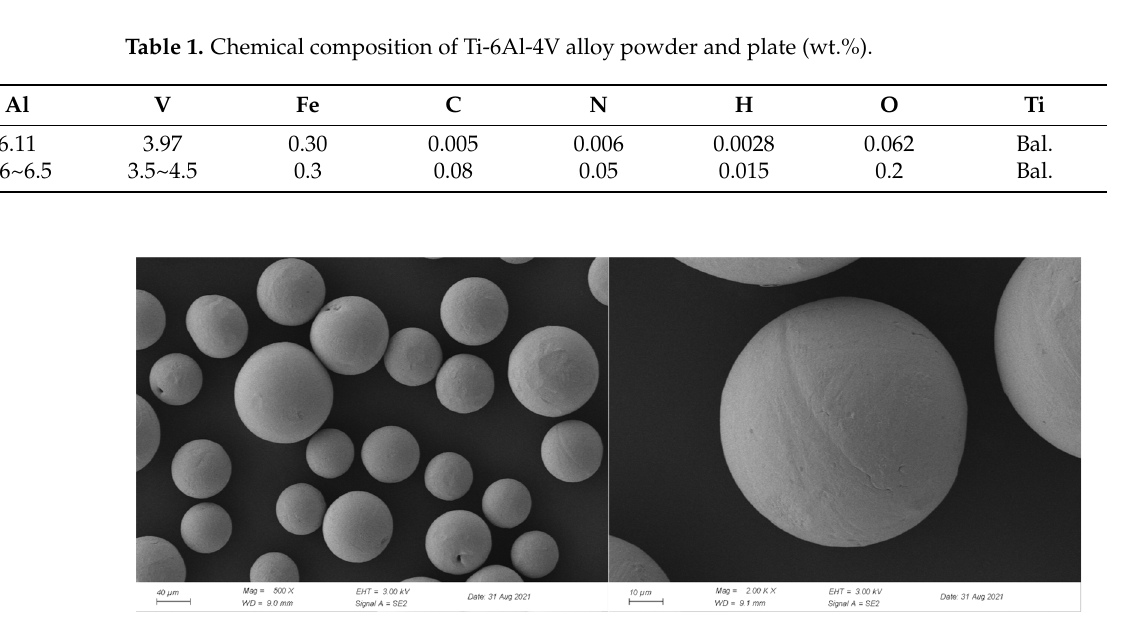
Figure 1. Morphology of the Ti-6Al-4V alloy powder under SEM.